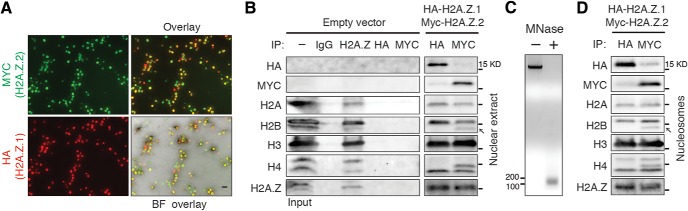
Distinct properties of HA-H2A.Z.1- and MYC-H2A.Z.2-containing nucleosomes. A, Representative image of immunocytochemical analysis of HA-H2A.Z.1 and MYC-H2A.Z.2 expression in unstimulated neurons. Approximately 70% neurons expressed both hypervariants. Scale bar, 20 μm. B, Co-IP assay from nuclear lysate preparation of neurons exogenously expressing a control vector or HA-H2A.Z.1 and MYC-H2A.Z.2. N = 3. C, Representative image of genomic DNA obtained from untreated or MNase-treated nuclei of neurons treated as described above. The band size of ∼150 bp indicates that MNase digestion predominantly produced mononucleosomes. N = 3. D, Co-IP assay from single nucleosome preparation of neurons exogenously expressing HA-H2A.Z.1 and MYC-H2A.Z.2. Antigen-antibody complex was resolved by electrophoresis and blotted for indicated histones. The 15-kDa protein ladder band is indicated in all panels. Arrow indicates unique band found only in anti-MYC precipitate. N = 3.